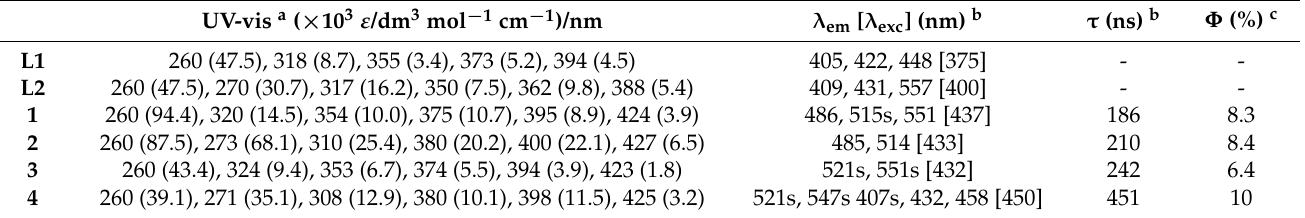
a in DMSO solution: L1 and L2 at [2 · 10 − 5 M] and complexes 1 – 4 at [10 − 5 M]. b In aerated DMSO solution. c In aerated DMSO